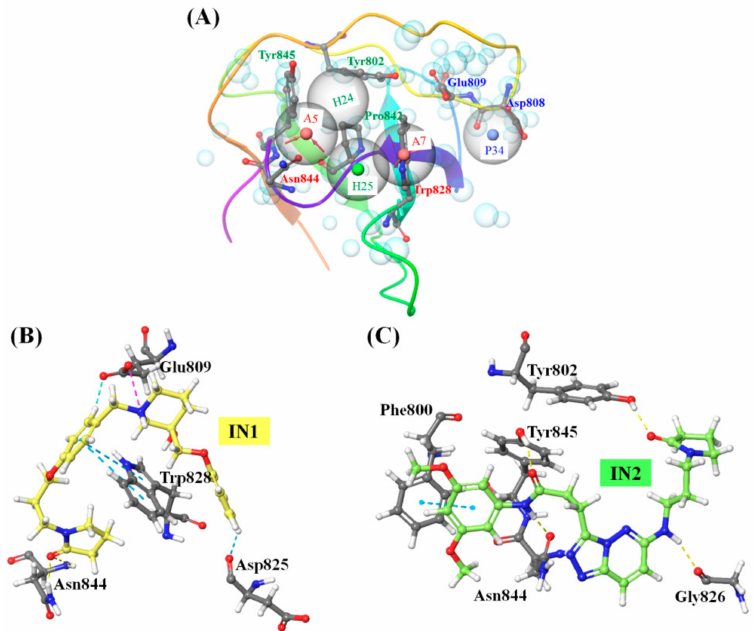
Figure 3. Results from the virtual screening performed for the identification of promising PLC γ 1 inhibitors ( A ) Generated pharmacophore hypothesis from PDB ID: 1YWO [18]. Selected five pharmacophore features are shown as large grey spheres, where A: H-bond acceptor. The red arrows indicate the direction of H-bond formation (“A” being the H-bond acceptor); H: hydrophobic group; P: Positive functional group, which is treated equivalent to H-bond donor. Cyan spheres represent excluded receptor volume shell. ( B ) and ( C ) Non-covalent interactions of IN1 and IN2, respectively, with PLC γ 1 (see Figure 2C for color